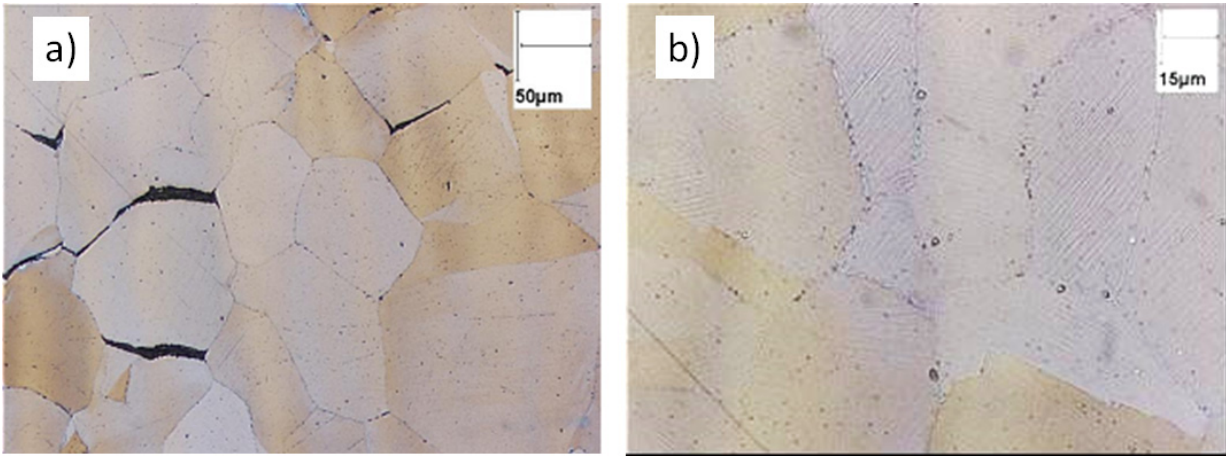
Figure 9. Optical micrographs of solution-treated 0.2 wt.% V steel after testing at 800 °C at a section close to the point of failure ( a ) showing intergranular cracking (200 × ) and ( b ) the presence of precipitates decorating the austenite grain boundaries (500 × ).